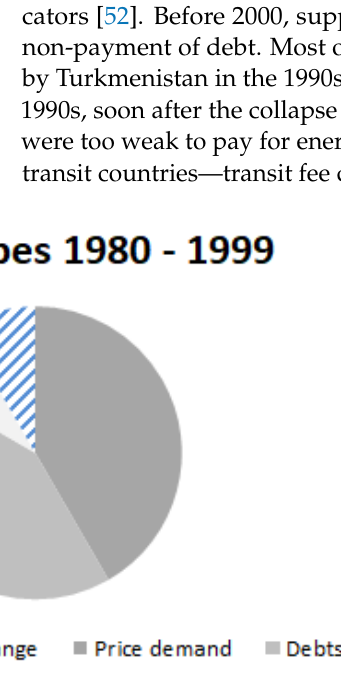
Figure 1. Classification of hold-up occurrences.